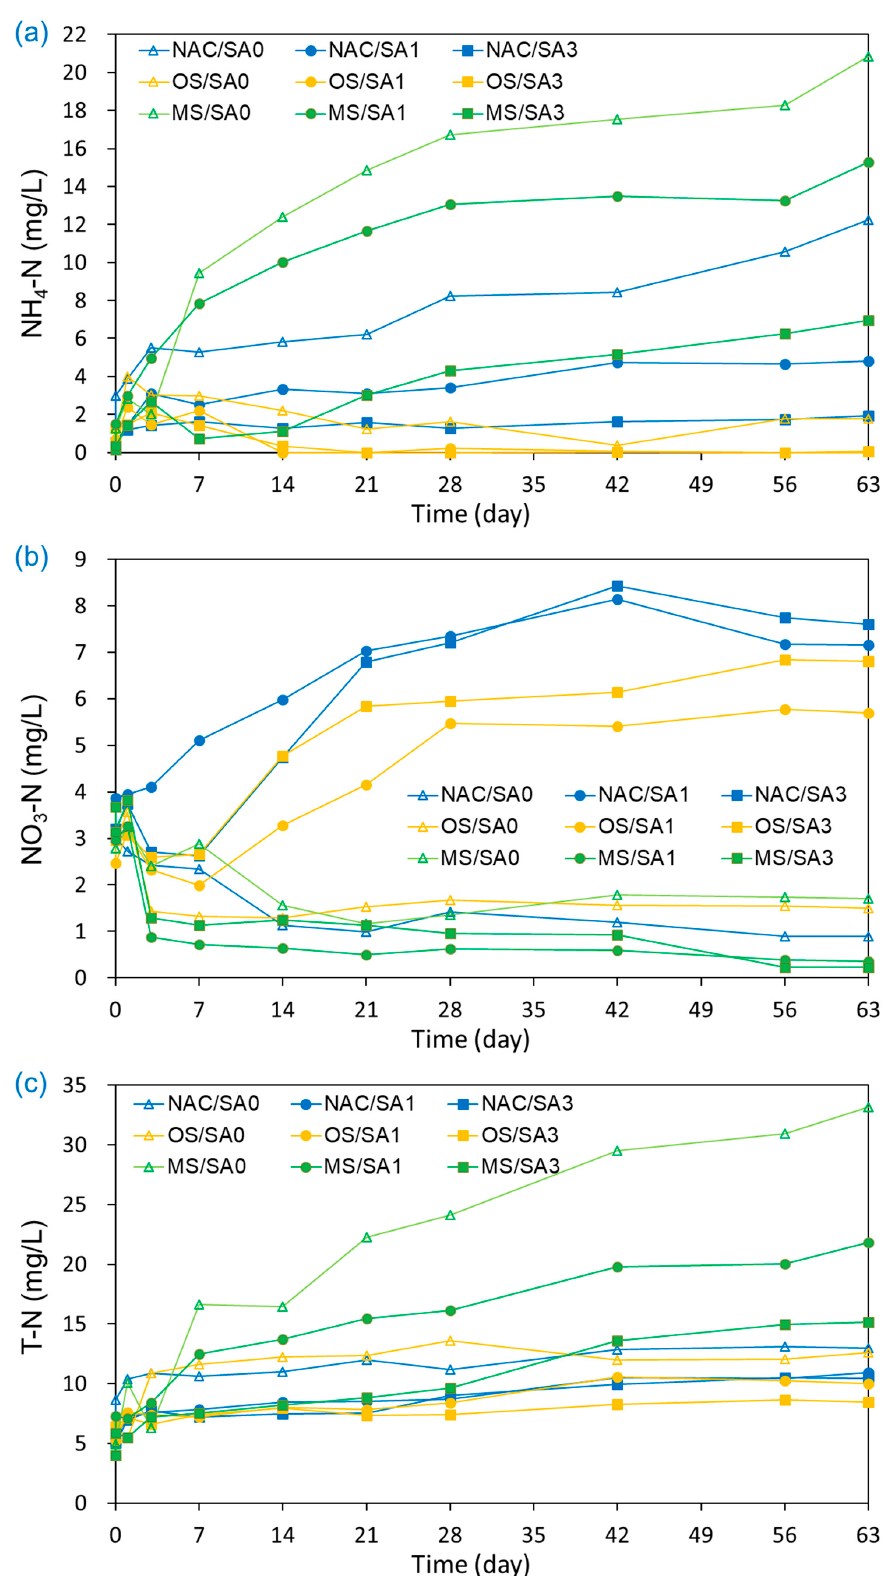
Figure 3. Effects of capping material and composition on the release of ( a ) NH 4 -N, ( b ) NO 3 -N, and ( c ) T-N from capped and uncapped sediments during the 63-day incubation period.